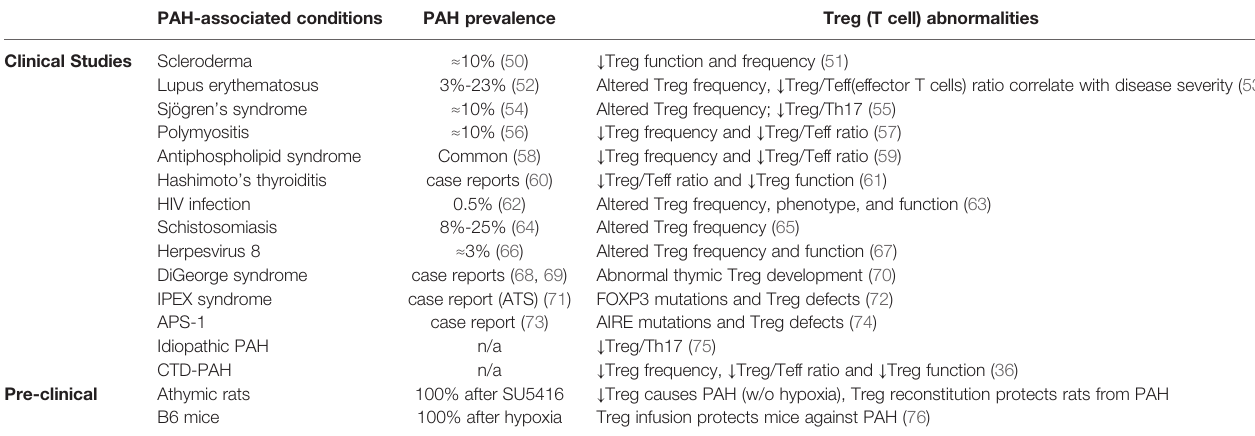
TABLE 1 | Clinical and pre-clinical studies show a relationship between Treg abnormalities and PAH-associated conditions. PAH-associated